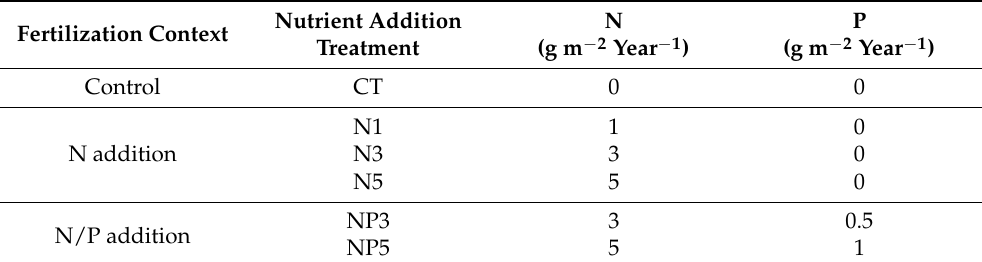
Figure 1. Location of the six experimental blocks located in the wetlands of the Qarlikturvik glacial valley, on Bylot Island (Nunavut, Canada). Table 1. List of fertilization treatments, the context associated with each treatment, and the amount of N and P in m 2 applied annually in each experimental block for 17 years in the tundra wetlands of Bylot Island, Nunavut.